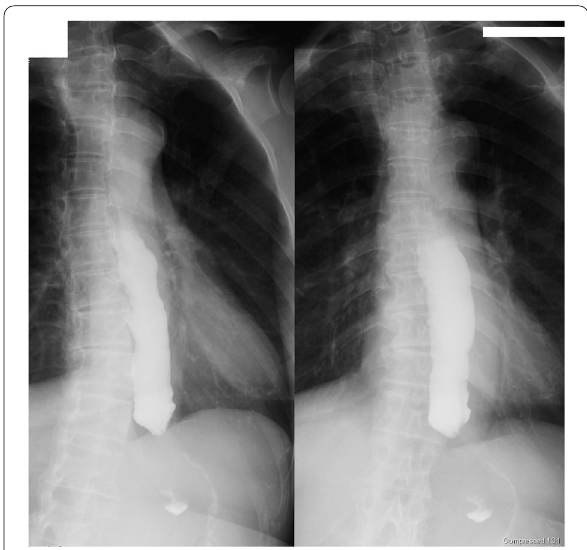
Fig. 2 Preoperative esophagogram showed a dilated esophagus and functional narrowing of the esophagogastric junction. A mouthful of contrast medium was retained in the esophagus until the end of the imaging